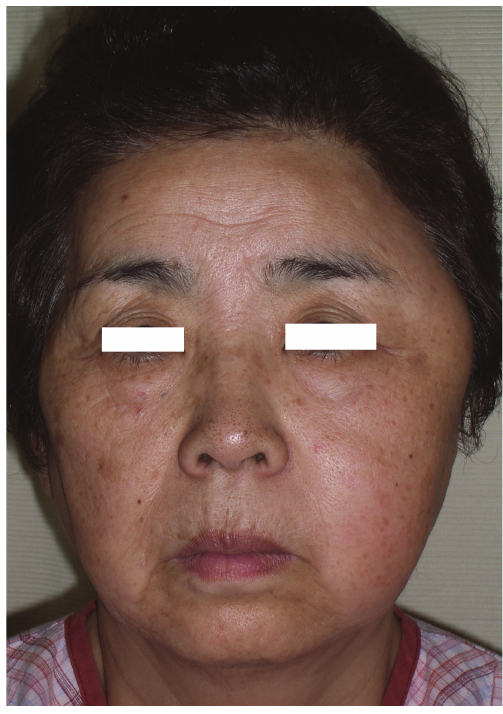
Figure 1: Preoperative view of the patient.